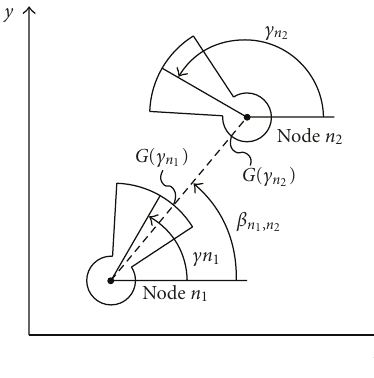
Figure 2: Example